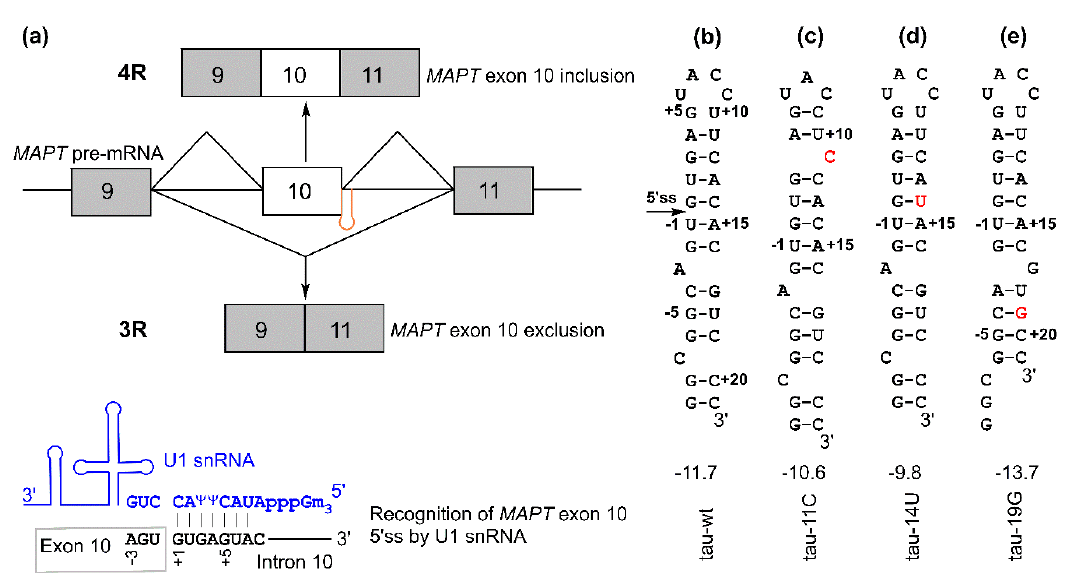
Figure 1. Microtubule-associated protein tau ( MAPT ) exon 10 5 ′ splice site recognition: ( a ) (top) schematic of MAPT pre-mRNA containing exon 9 (gray box), exon 10 (white box), and exon 11 (gray box). The regulatory hairpin (shown in orange) is located at the junction of exon 10 and intron 10, and 4R and 3R isoforms are generated based on the inclusion or exclusion (skipping) of MAPT exon 10. (bottom) Schematic of the recognition of the 5 ′ splice site by U1 small nuclear RNA (snRNA) (shown in blue). ( b – e ) Secondary structures for tau pre-mRNA exon 10 splice site hairpins. The values shown below the structures are folding free energies (in kcal/mol, at 1 M NaCl, pH 7.0) predicted by RNA structures [29,30]. The disease-causing mutations are shown in red. The +11C and +19G mutations result in structural rearrangement in the top and bottom stems, respectively [29]. The 5 ′ splice site located at the 5 ′ arm of the hairpin is indicated with an arrow in panel (b). The 5 ′ and 3 ′ arms of the hairpin may contain the exonic splicing enhancer elements and intronic splicing silencer/modulator sequences, respectively, as potential binding sites of trans -acting protein factors [31–34].